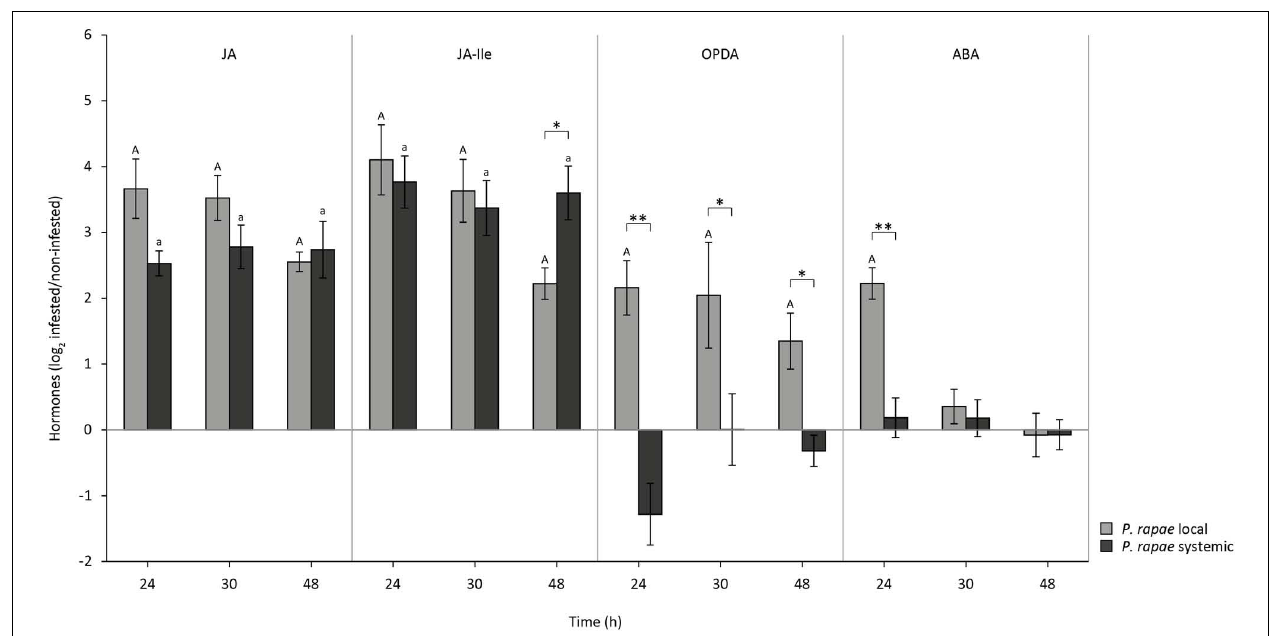
Statistics were performed on log 2 -transformed data. Letters indicate statistically significant differences in compound levels between leaves of non-infested control plants and damaged local leaves (capital letters) and undamaged systemic leaves (small letters) of P. rapae -infested plants. Data were analyzed per time point using Student’s t -test ( P < 0.05). Asterisks indicate statistically significant differences in compound levels between the damaged (local) and undamaged (systemic) leaves of P. rapae -infested plants. Data were analyzed per time point using Student’s t -test (** P < 0.01; * P <